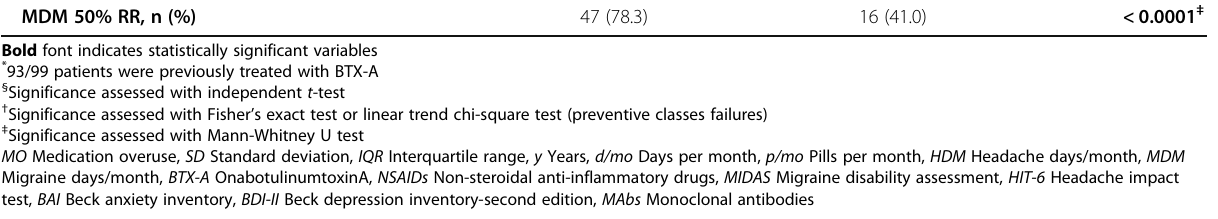
Table.1 Baseline characteristics and their association with medication overuse resolution after 6 administrations of anti-CGRP MAbs (Continued) Treatment response rate HDM 50% RR, n (%) Bold font indicates statistically significant variables * 93/99 patients were previously treated with BTX-A § Significance assessed with independent t -test † Significance assessed with Fisher ’ s exact test or linear trend chi-square test (preventive classes failures) ‡ Significance assessed with Mann-Whitney U test MO Medication overuse, SD Standard deviation, IQR Interquartile range, y Years, d/mo Days per month, p/mo Pills per month, HDM Headache days/month, MDM